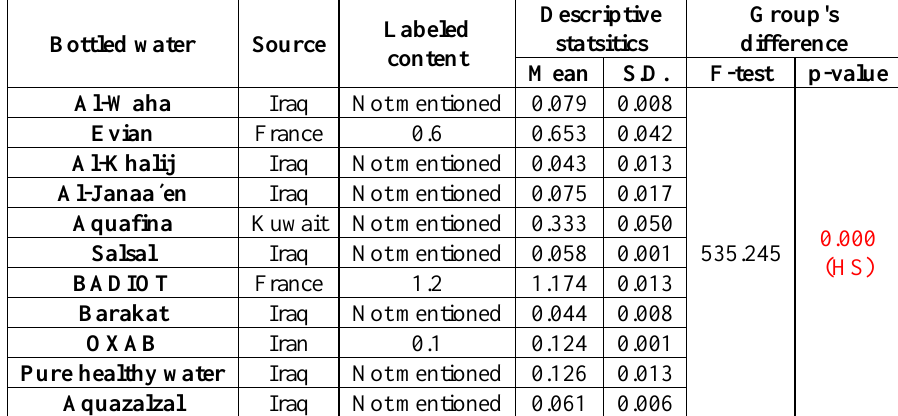
Table 1: Comparison the Fluoride Concentration (mg/L) among Bottled Water Bottled